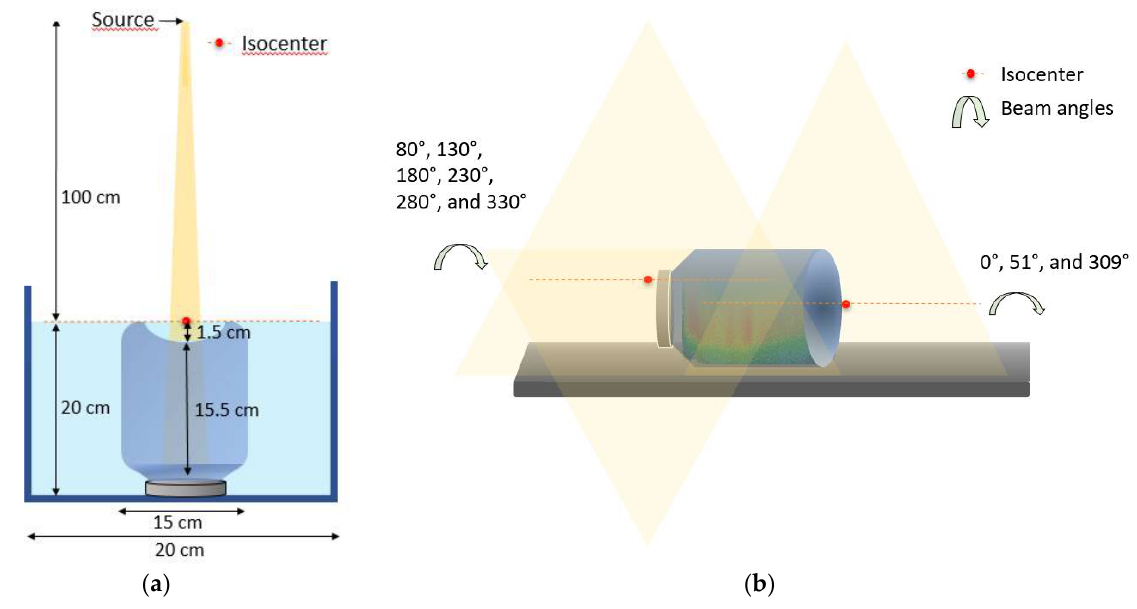
Figure 12. Irradiations setup for calibration ( a ) and for CSI dose verification ( b ).